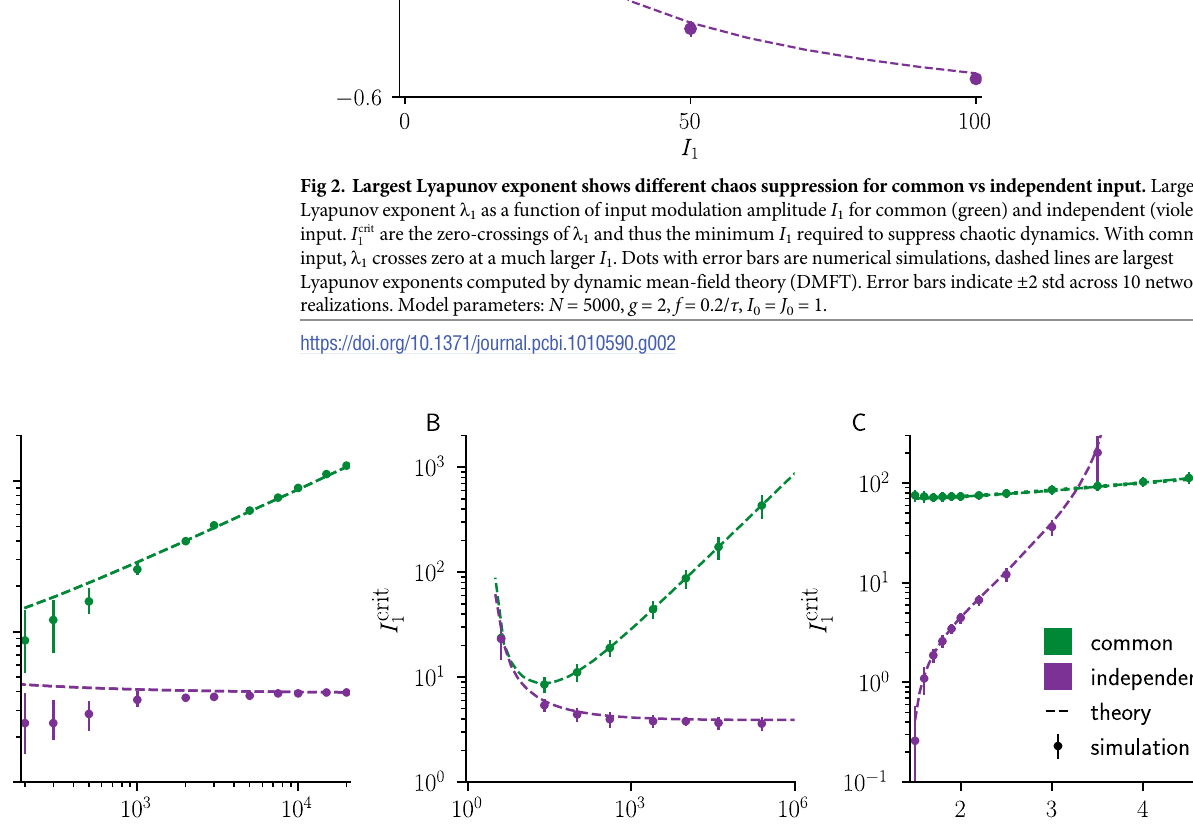
on network size N . 1 on 1 on gain parameter g for low input frequency f . Close to 1 ffiffiffiffiffiffiffiffiffiffi p ¼ J ¼ , in B ; f = 0.01/ τ in C , N = 5000 in B K = N 0 0